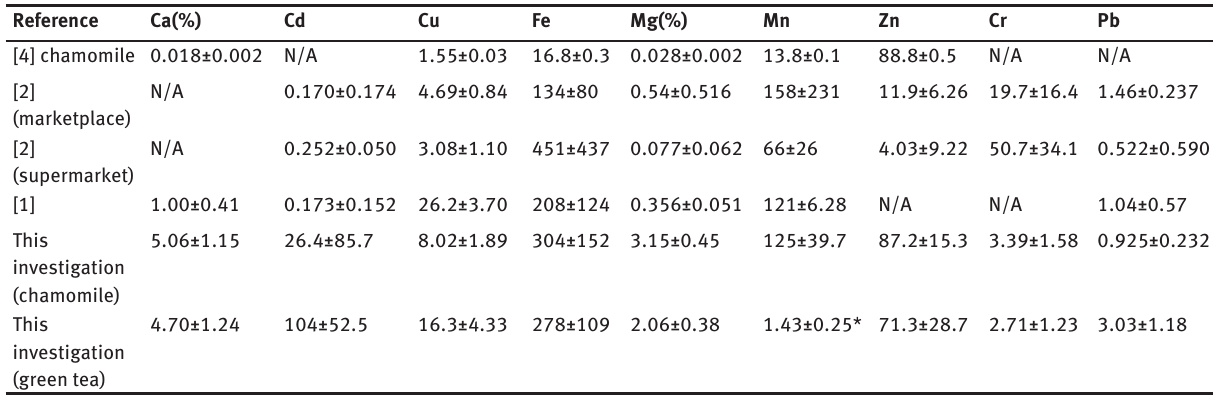
Table 7: Comparison of the previously published results for tea samples purchased at Croatian and Polish market expressed on dry basis (mean±SD)/mg kg −1